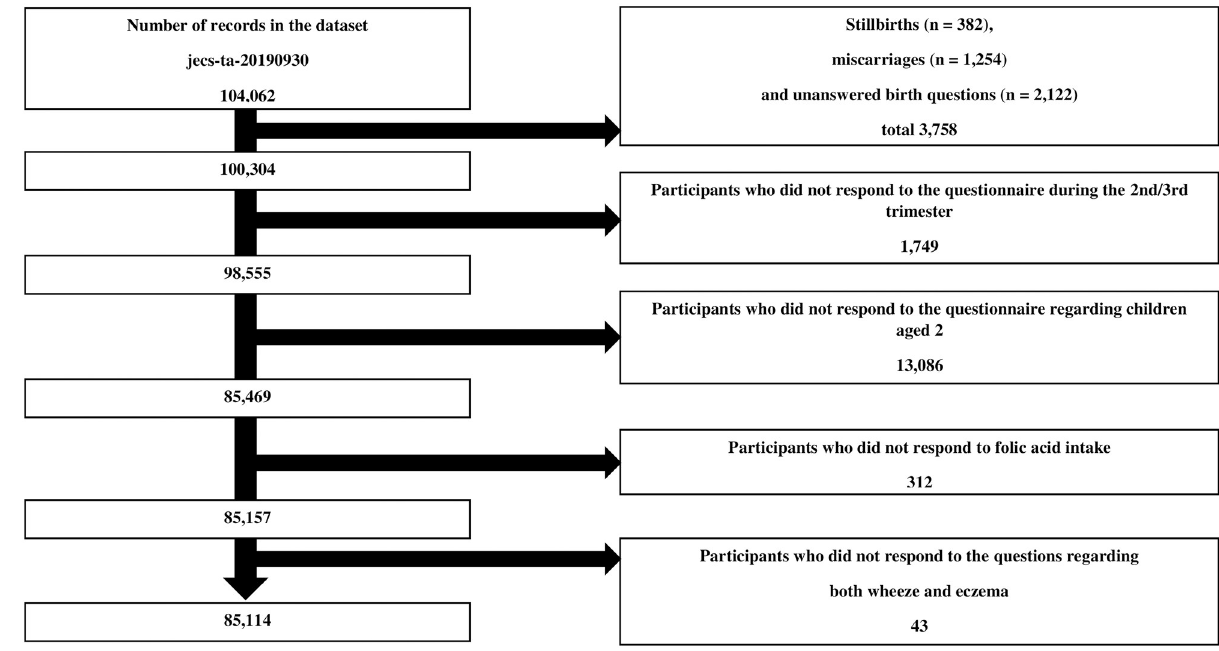
Fig 1. Flow chart of the participant